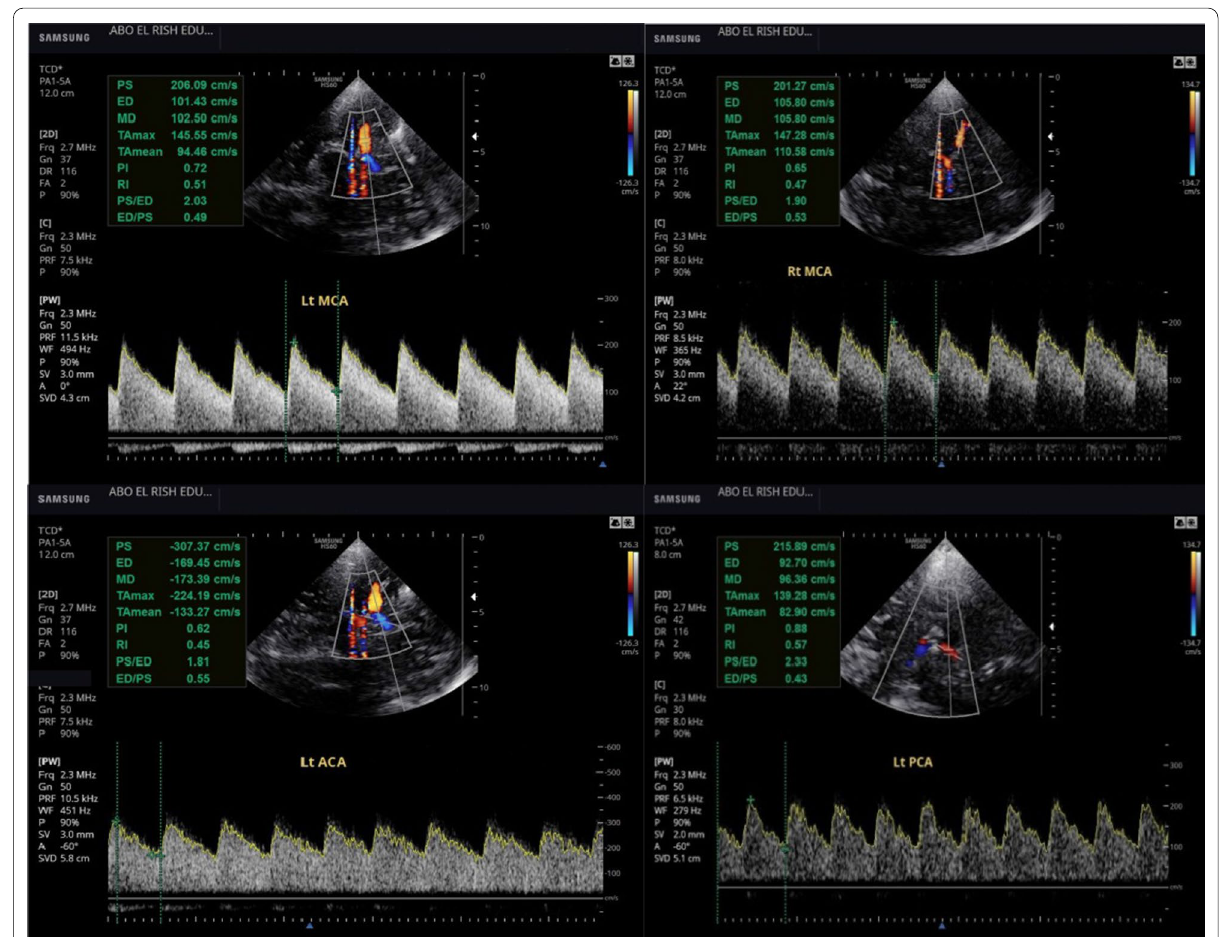
Fig. 3 6 years old female patient on occasional blood transfusion, Transcranial Doppler measurements showing right MCA TAmax of 147 cm/sec, left MCA TAmax of 145 cm/sec and Lt ACA TAmax of 209 cm/sec, parameters indicating high risk of